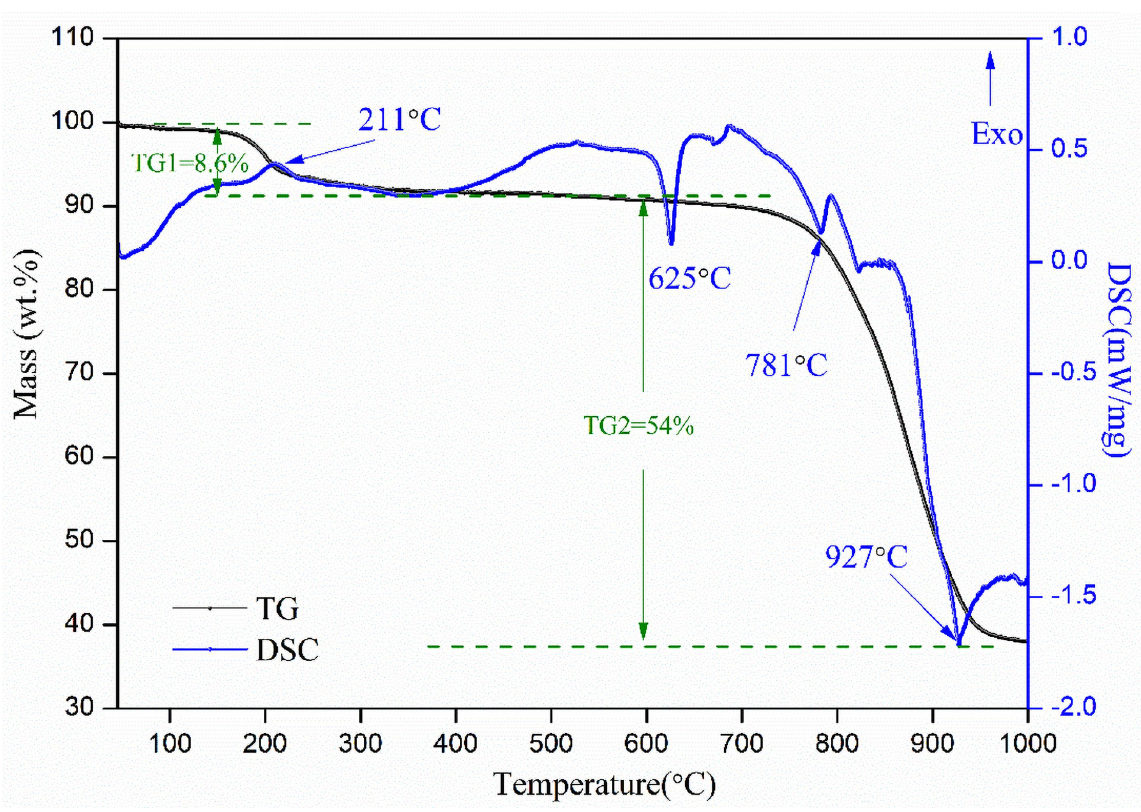
Fig 3. The TG-DSC curve of the industrial waste